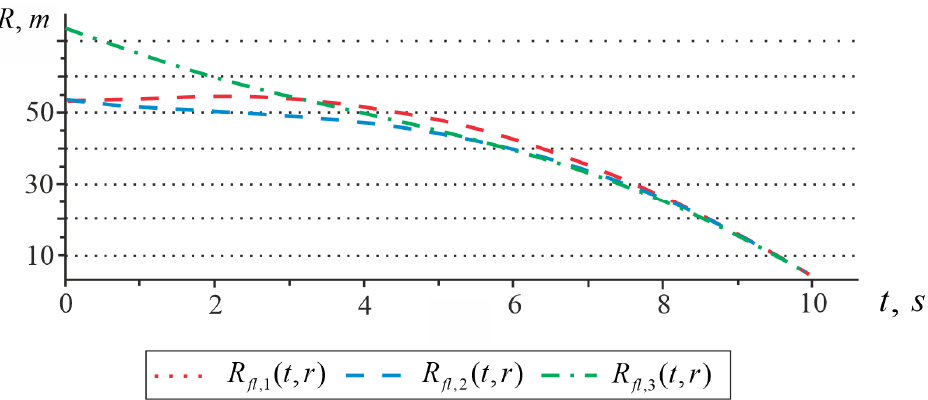
Figure 16. Calculated changes in distances along each of the beams while a helicopter is landing.